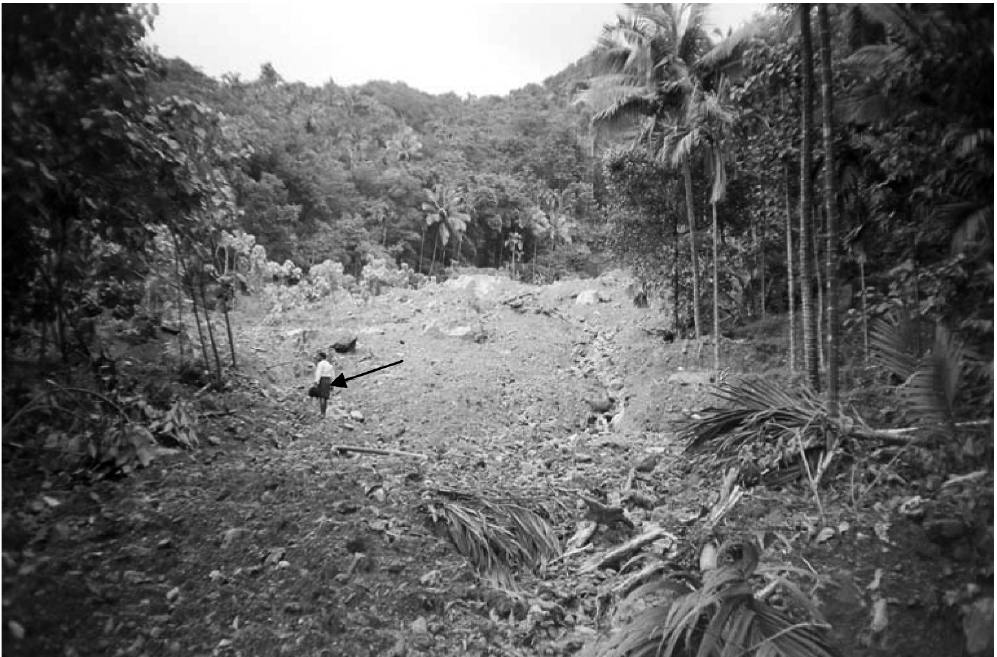
Fig 2: This photograph shows how the landslides have uprooted the whole soil and vegetative cover, when compared with the surroundings. The man in the picture is a farmer, whose farm land is at the higher ridge of the landslide affected